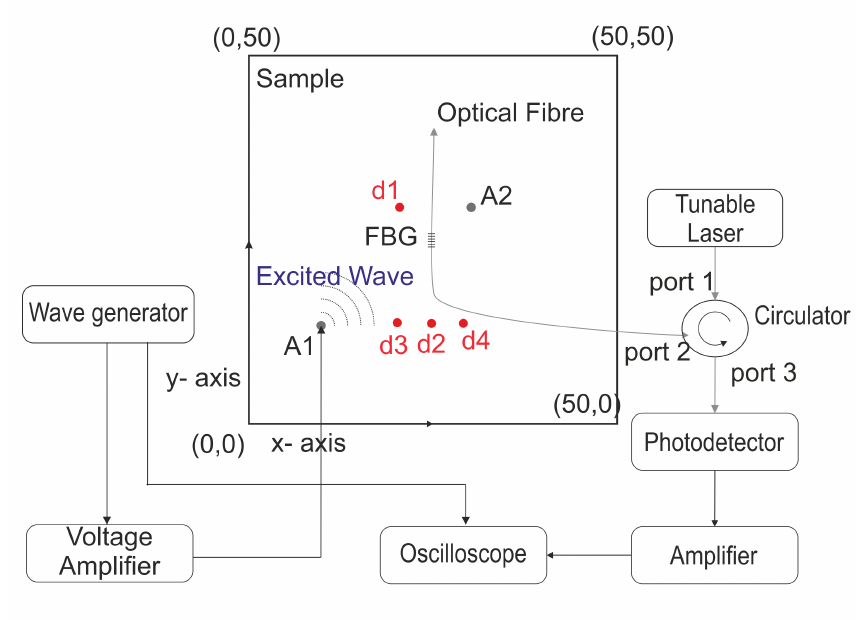
Figure 6. Schematic of the experimental set-up.